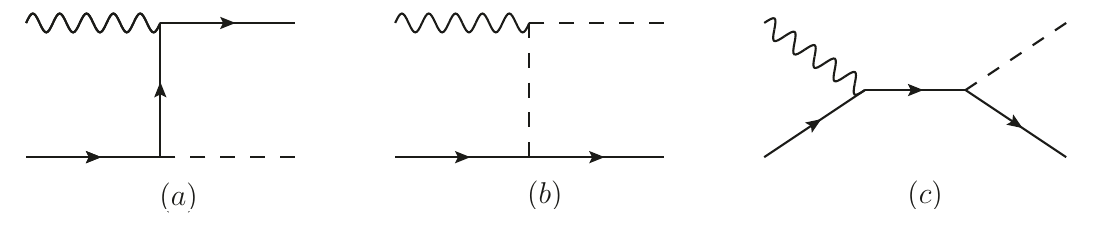
Figure 4 . Diagrams for the process γ + q → ‘ + LQ contributing to the resonant leptoquark production at O ( α )